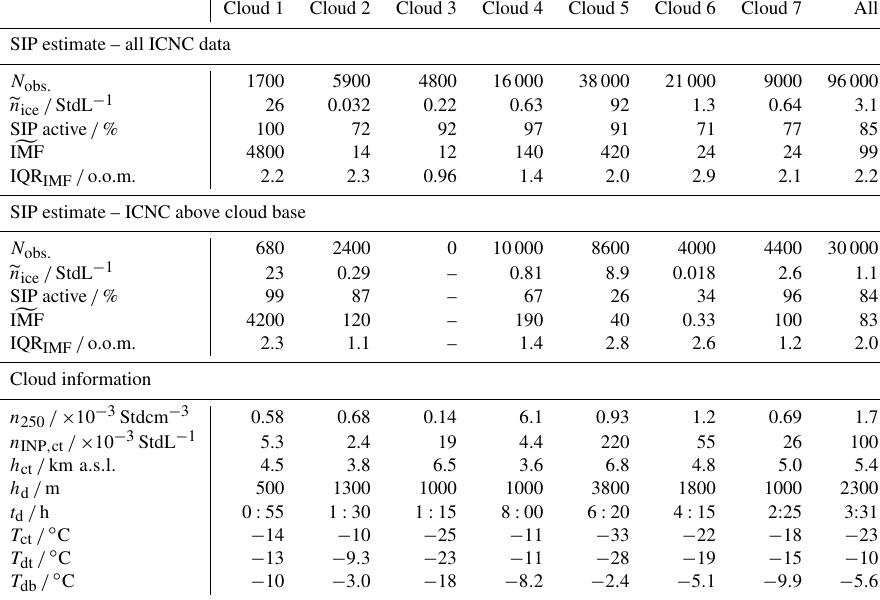
Table D1. Overview of the secondary ice production (SIP) analysis per investigated cloud and environmental information for each cloud. For each cloud the total number of ice crystal number concentration (ICNC) observations ( N obs . ), and the median ICNC ( (cid:101) n ice ), the times when SIP was active (SIP active, i.e., percentage of IMFs > 1), and the median IMF ( (cid:103) IMF) and its interquartile range (IQR IMF , in orders of magnitude) are presented for all ICNC data available and ICNC data above a detectable cloud base. Further, the concentration of particles with radii ≥ 250nm and INPs at cloud top before the event ( n 250 , ct , n INP , ct ), the cloud height ( h ct ), the height ( h d ) and time ( t d ) over which ICNC was obtained, and the temperatures at cloud top ( T ct ) and top ( T dt ) and bottom ( T db ) of available ICNC data are given. In the last column, the total number of observations ( N obs . ) and averages (weighted by number of observations) of the variables are given combined for all clouds.